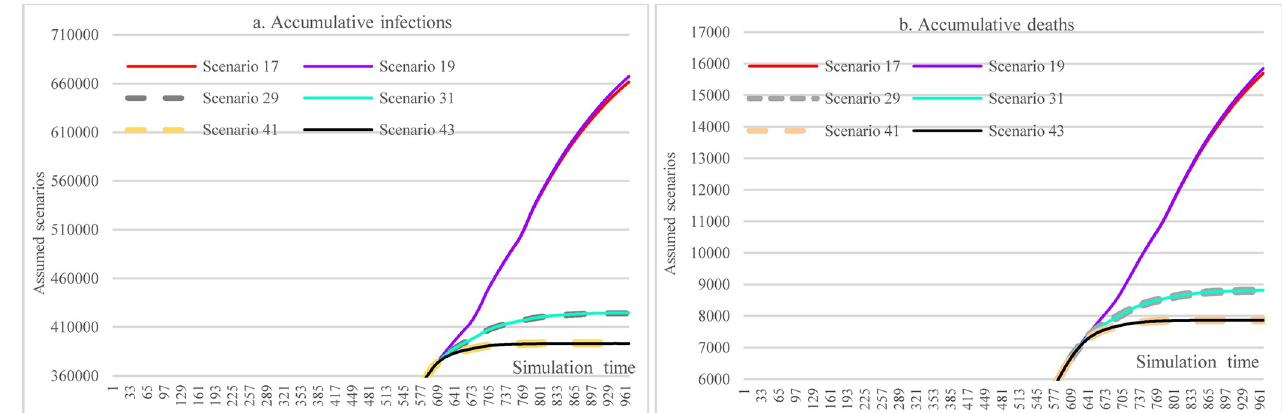
Fig 10. Impacts of the immunological period on cumulative infection and cumulative deaths in scenario analysis (48% mask-wearing).